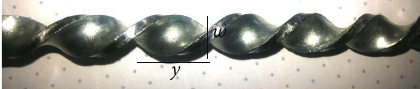
Figure 4: Geometries of typical twisted